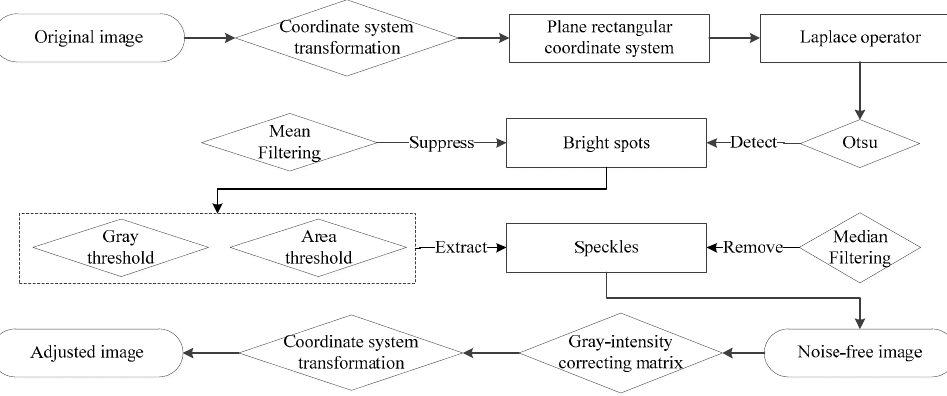
Figure 6. Flow diagram for image pre-processing.